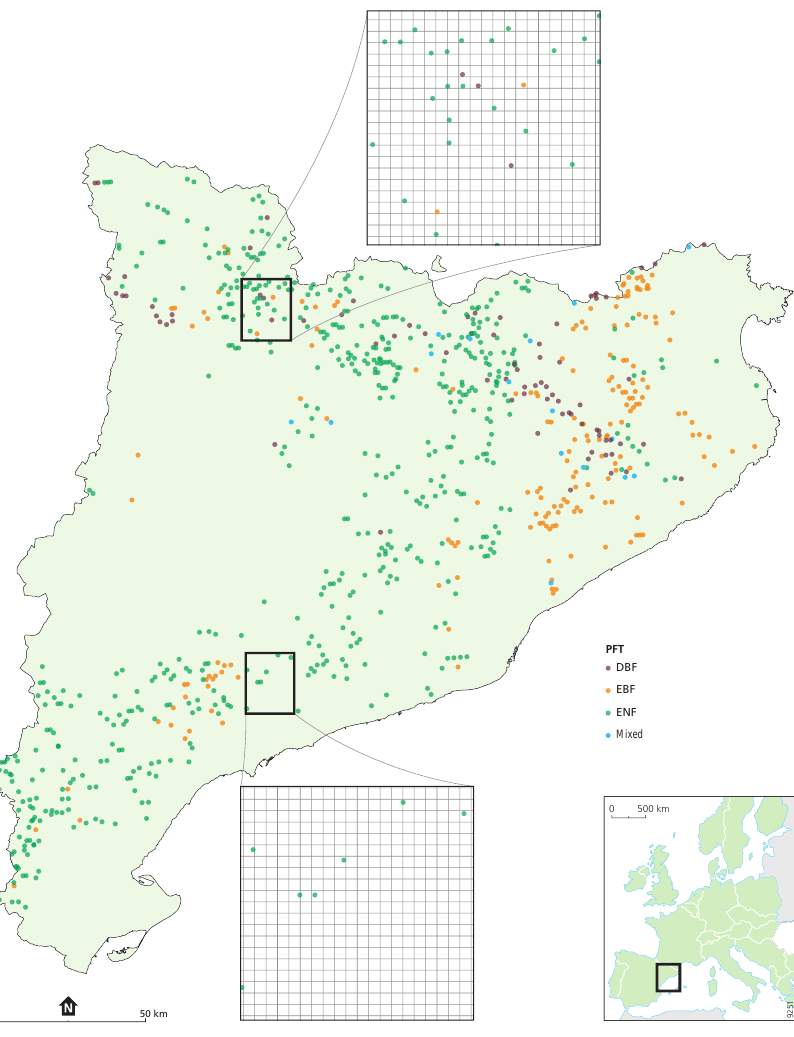
Figure 1. Map showing the forest plots’ ( n = 846) location in the region of Catalonia, northeastern Spain. Two zoom windows are included showing the density of the plots, one with high density and one with low density, relative to the MTCI 1km pixel grid. DBF is deciduous broadleaf forest, EBF is evergreen broadleaf forest, ENF is evergreen needleleaf forest, and mixed is mixed forest.